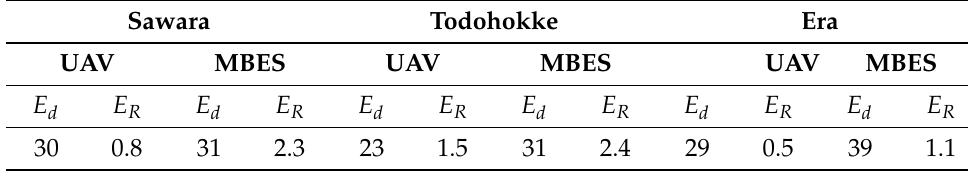
Table 4. Average of displacement and rotation errors for synthetic scenes. E d : displacement error (mm); E R : rotation error ( ◦